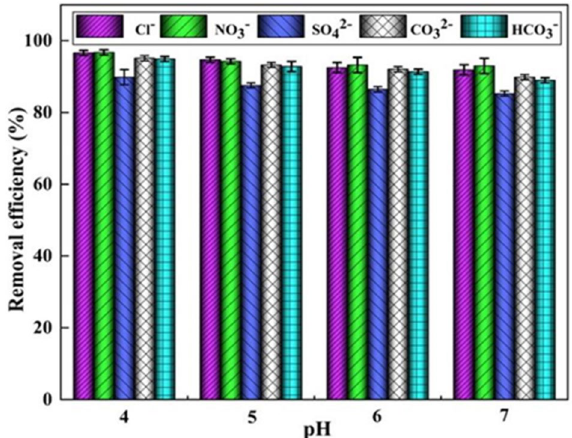
Figure 11. Effect of anions on F − adsorption on Al-DA as a function of the pH (ion concentration is 100 mg/L, Sorbent dose 4 g/L, contact time is 2 h).